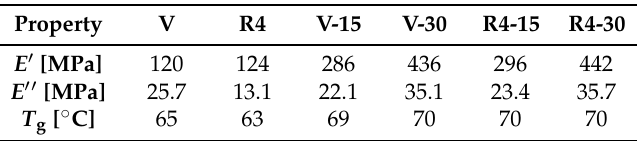
Table 4. Comparison between DMTA results of neat polymer (V), 15% and 30% filled composites (V15, V30) and 15%, 30% filled composites prepared after multiple recyclings of the polymer matrix (R4-15, R4-30).